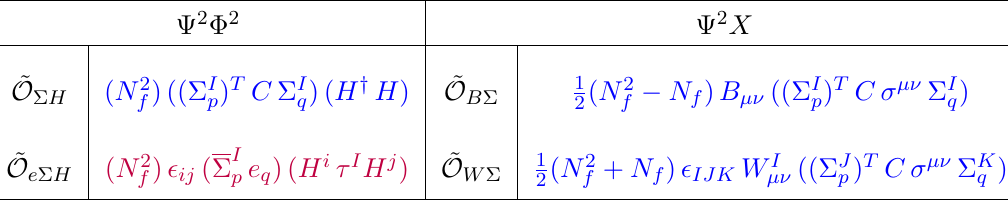
Table 8 . SM extended by Left-Handed Triplet Fermion ( Σ ): additional operators of dimension 5. Here i, j are the SU(2) indices. τ I is the SU(2) generator. I = 1 , 2 , 3 and p, q = 1 , 2 , · · · , N f are the flavour indices. The operator in red violates lepton number. Ψ 2 Φ X